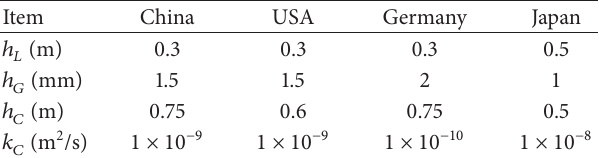
Table 1: Minimum requirements for the liner